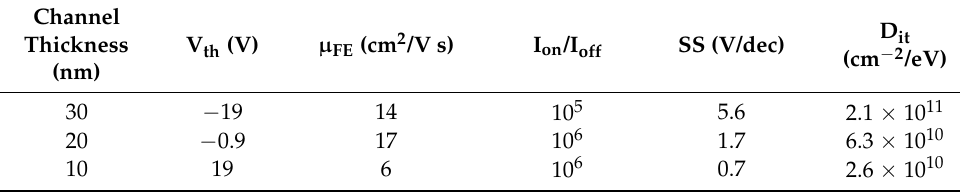
Table 2. Electrical parameters of a-InGaZnO TFTs with different channel thicknesses.